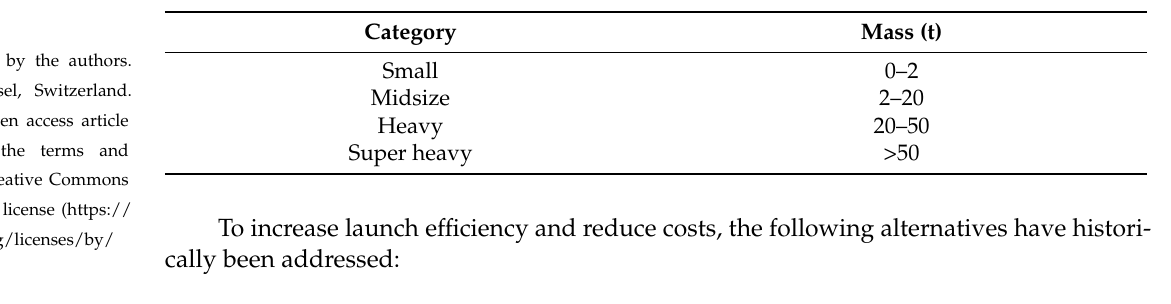
Table 1. Classification of launch vehicles according to its